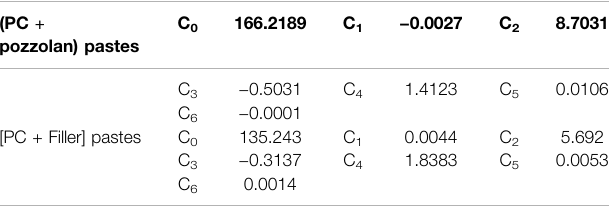
TABLE 4 | Optimum values of coef fi cients and the constant for the analytical modelshownin Eq.3 .Themodelcanbeusedtoestimatethe24